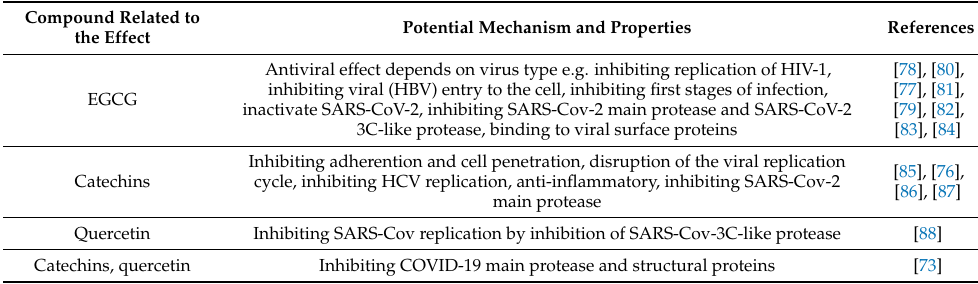
Table 1. Research on antiviral properties of green tea